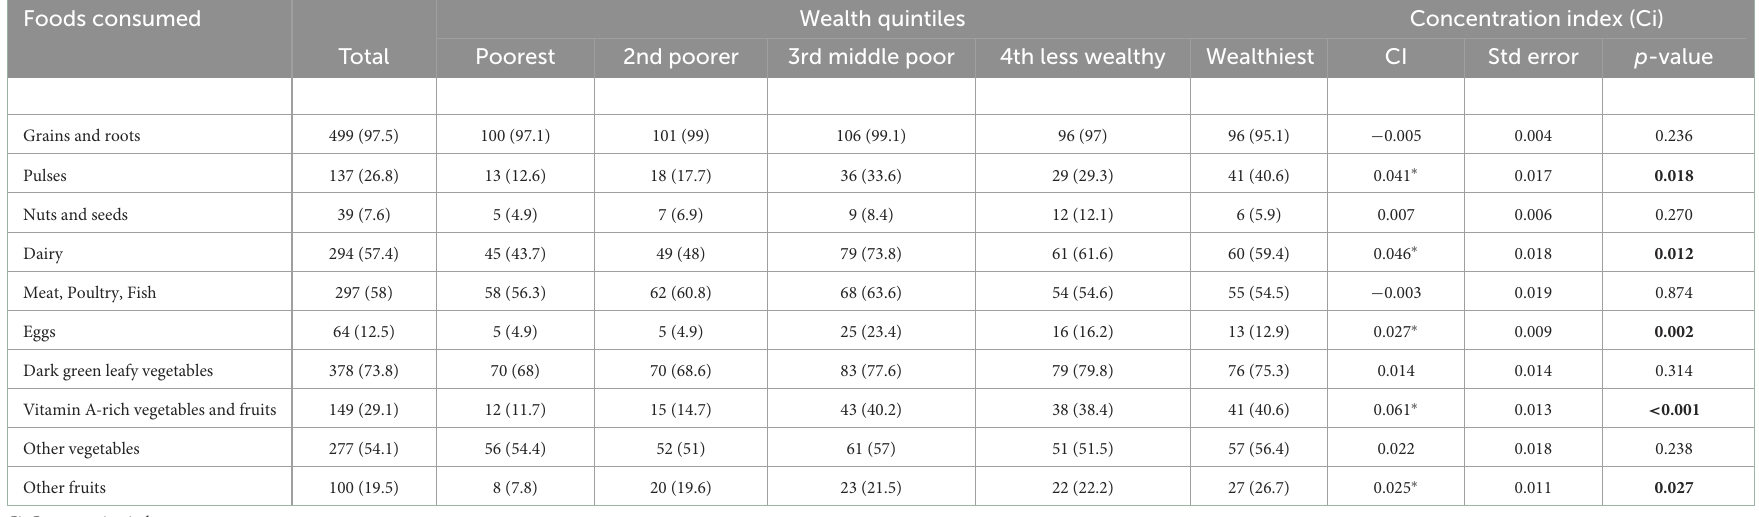
TABLE 4 The proportion of types of foods consumed among individuals across household socioeconomic status in a hypermarket study in Western Region, Kenya ( n = 512). Foods consumed